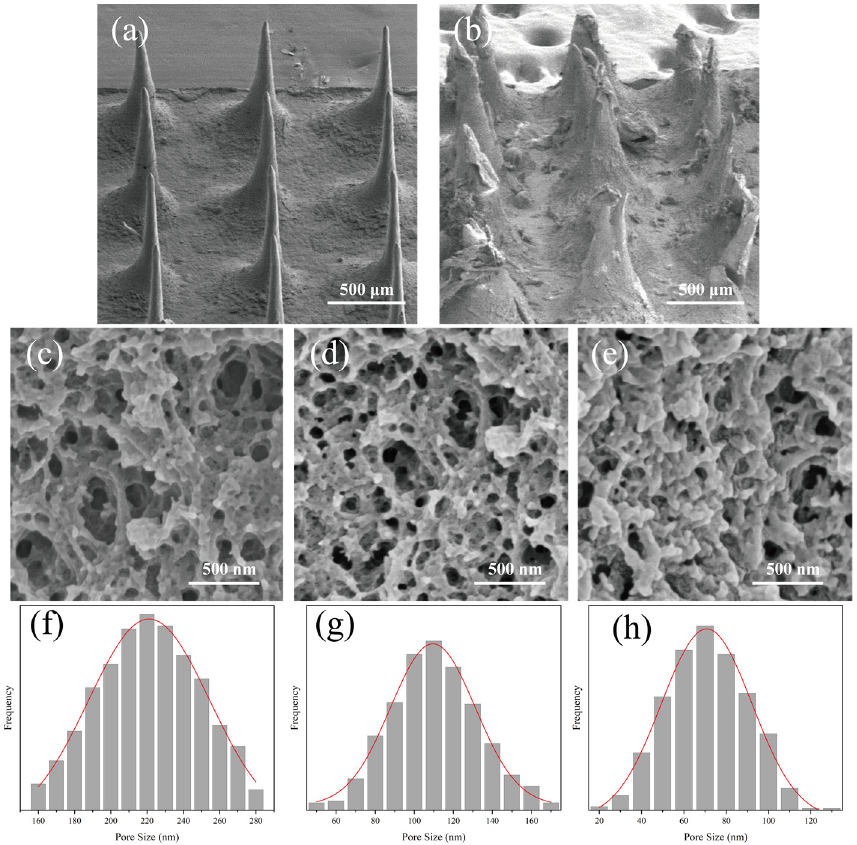
Figure 8. SEM images of the surface and section morphology of MT/SF@MNs: ( a , b ) surface images before and after microneedle swelling of Pro/MT/SF = 10/1/100, ( c – e ) cross-section images of Pro/MT/SF = 10/1/100, 20/1/100, 30/1/100 after microneedle swelling, and ( f – h ) pore size frequency distribution datagrams of Pro/MT/SF = 10/1/100, 20/1/100, 30/1/100 after microneedle swelling. Table 1. Pore size of Pro/MT/SF in different proportions.